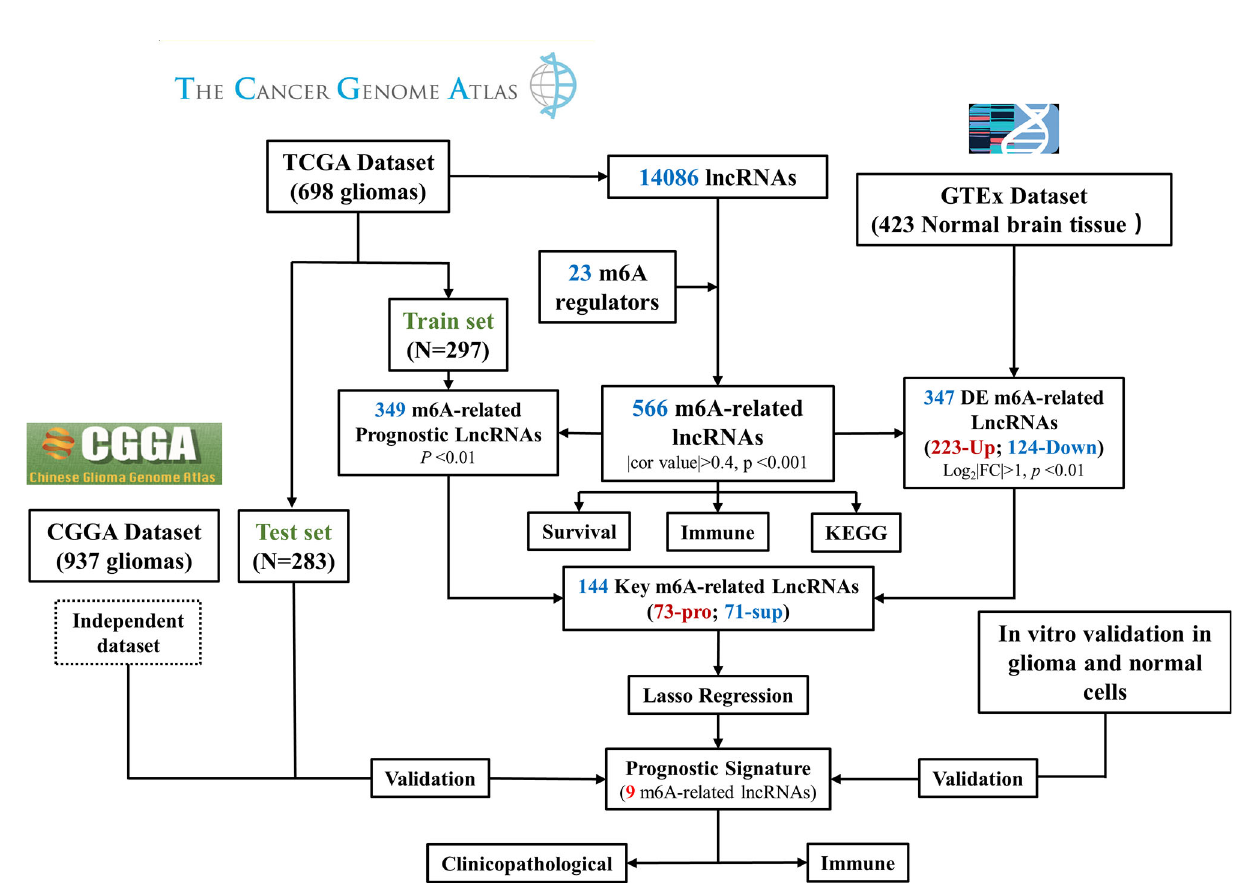
FIGURE 3 | Flow chart of this study. DE, differentially expressed; Pro, promotor; Sup, suppressor. RT – PCR Quantitative Real-Time Polymerase Chain